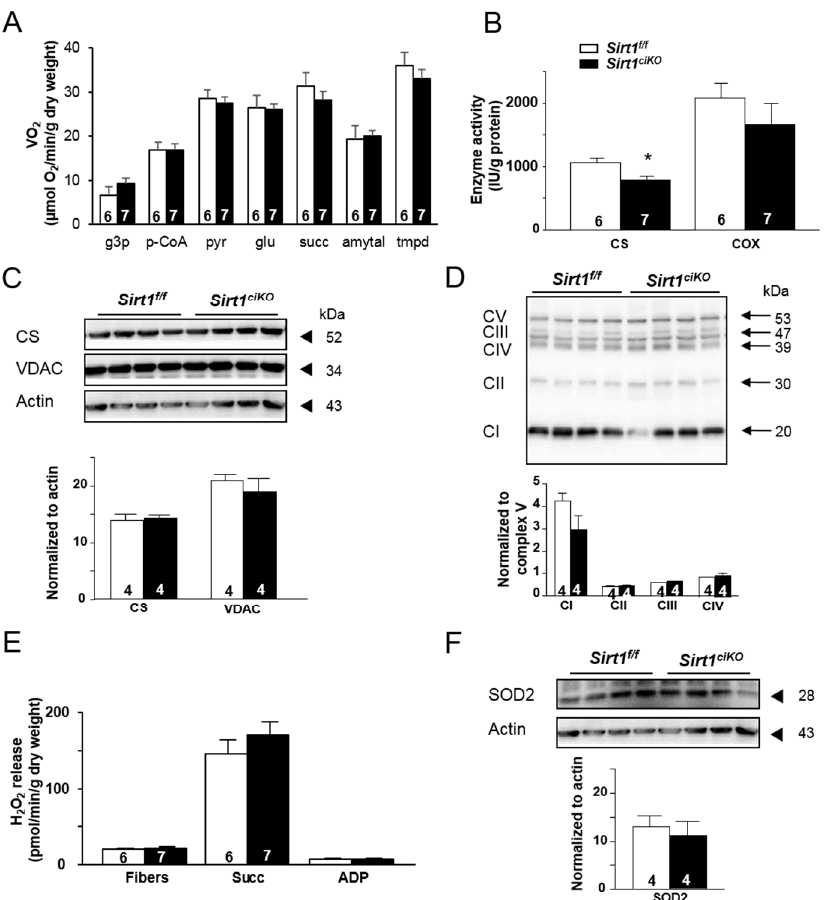
Figure 4. Cardiac mitochondrial phenotype of cardiac-specific knockout mice after 11 months of Sirt1 deletion. ( A ) Rate of respiration after successive addition of L -glycerol-3-phosphate (4 mM) (g3p), palmitoyl-CoA and carnitine (100 µM and 2 mM) (p-CoA), pyruvate (1 mM) (pyr), glutamate (10 mM) (glu), succinate (15 mM) (succ), amytal (1 mM), and N , N ’, N ´-tetramethyl-phenylenediamine dihydrochloride (TMPD)-ascorbate (0.5 mM). ( B ) Citrate synthase (CS) and cytochrome c oxidase (COX) enzymatic activities. ( C ) Immunoblotting of citrate synthase (CS) and voltage-dependent anion channel (VDAC) in LV homogenates. ( D ) Total protein content of 5 subunits of oxidative phosphorylation complexes: C-I-20 (complex I (CI)), C-II-30 (complex II (CII)), C-III-Core 2 (complex III (CIII)), C-IV-COXI (complex IV (CIV)), and C-V- α (complex V (CV)). Protein content for CI, CII, CII, and CIV was normalized using CV as internal control. ( E ) Net rate of H 2 O 2 release by the mitochondrial electron transport chain measured following sequential addition of succinate (5 mM), and ADP (1 mM). ( F ) SOD2 protein content in LV homogenates. (A–B and E: n = 6 to 7 per experimental group, C–D and F: n = 4 per experimental group), * p < 0.05 Sirt1 f / f versus Sirt1 ciKO